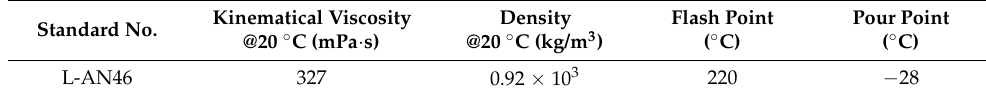
Table 2. Basic parameters of L-AN46 total loss system oil.